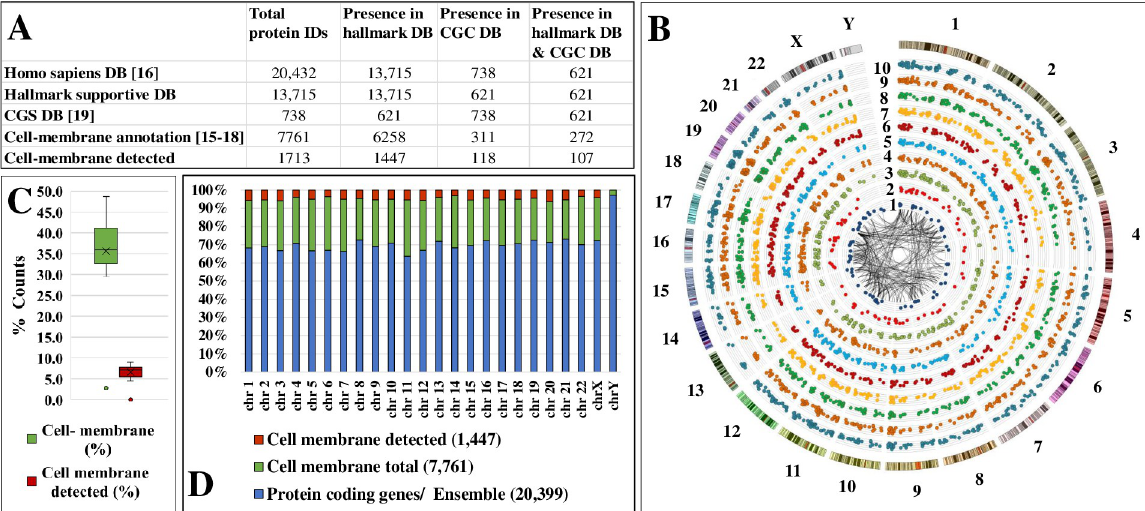
Fig 1. Cell-membrane proteins mapped to the cancer hallmarks. ( A ) Protein counts with hallmark association. (B) Circos plot of detected SKBR3 cell-membrane proteins mapped to their position in the human genome represented by 23 chromosomes, and categorized into 10 radially distributed cancer hallmarks. Hallmark categories, from inside-out (low-to-high counts): 1-DNA replication, chromosome organization, and telomeres; 2-Glycolysis, gluconeogenesis, and carbohydrate metabolism; 3-Angiogenesis; 4-Inflammatory response; 5-Cell death, apoptosis, senescence, aging; 6-Disease mutation; 7-Cell cycle division, growth, and proliferation; 8-Immune system processes; 9-Cell adhesion and motility; 10-Cell communication and signaling. The inner PPI network was constructed with proteins for which the STRING interaction score was � 0.995. ( C ) Percent counts of cell-membrane proteins encoded on, and detected from, each chromosome. ( D ) Distribution of coded (total and cell-membrane) and detected proteins per chromosome.